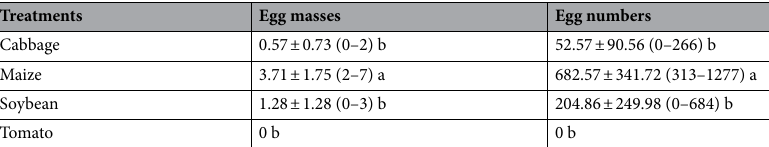
Life table analysis. The results of development time, survival, reproduction and longevity of FAW fed on cabbage, maize (ear and leaves), soybean, tomato, and artificial diet are represented in Table 2. No statistical analysis was conducted on egg stage, since the study started with new larval hatching at the same time, and 3 days after oviposition. L1 stage was significantly shorter in cabbage, soybean and maize ear treatments, compared to maize leaves. L2 stage was significantly shorter in soybean compared to artificial diet. L3, L4, L5, L6 + L7 stages were significantly shorter in maize (ear and leaves) compared to artificial diet. In addition, the pre-pupal stage was shorter in soybean-reared individuals compared to maize leaves-reared individuals, whereas the pupal stage was significantly shorter in maize leaves compared to artificial diet and maize ear treatments (Table 2, Fig. 2).